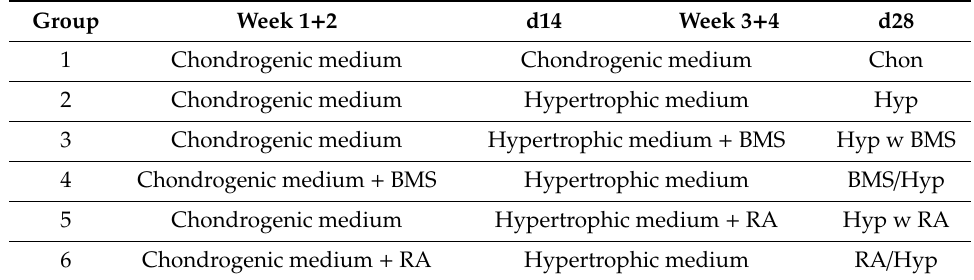
Table 1. Classification of aggregates into di ff erent test and associated control groups with di ff erent composition of proliferation